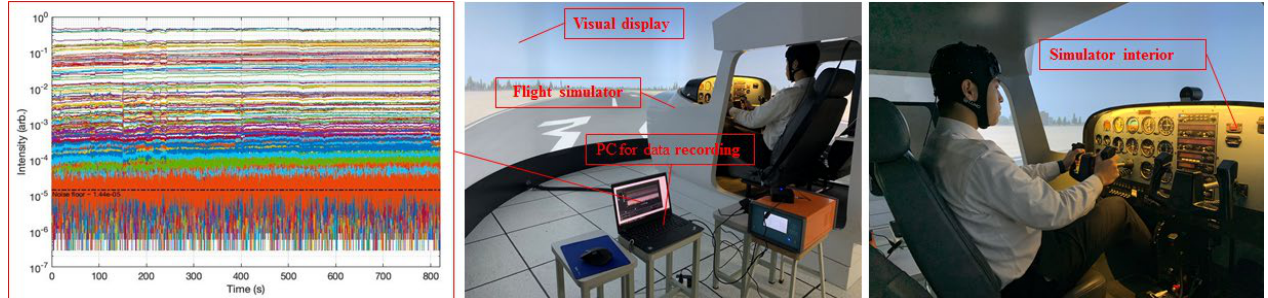
Figure 3. Experimental scene.